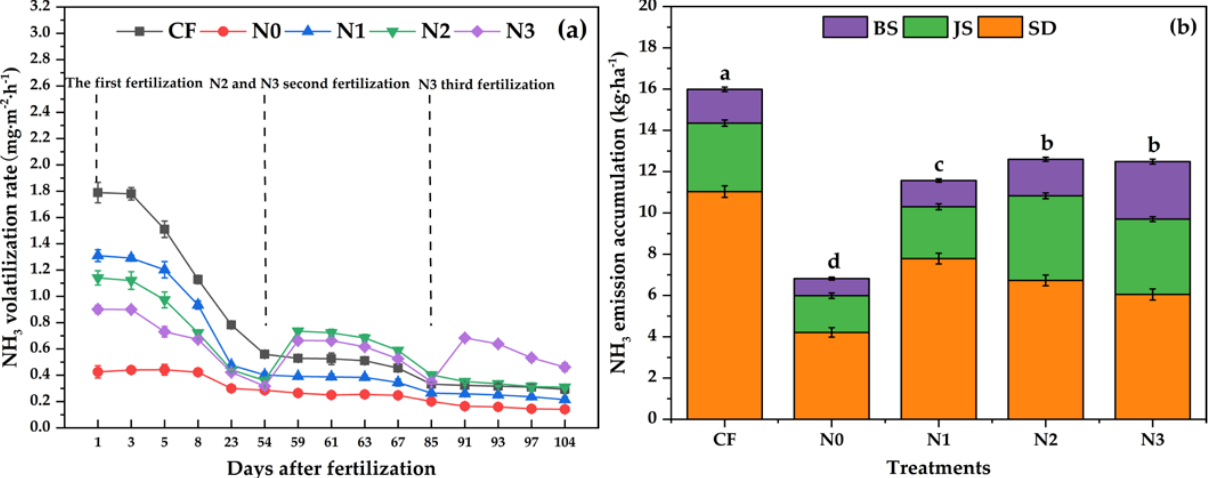
Figure 4. Substitute organic fertilizer for chemical fertilizer and fertilization with stage application method affected ( a ) NH 3 volatilization rate and ( b ) NH 3 volatilization accumulation during wheat growth. Note: Different colored columns in ( b ) represent different growth stages; SD, after sowing to jointing before fertilization; JS, after fertilization at jointing to before fertilization at booting; BS, after fertilization at booting stage. Different lowercase letters indicate significant differences for NH 3 emission accumulation among different treatments throughout the whole growing period (LSD test, p < 0.05).